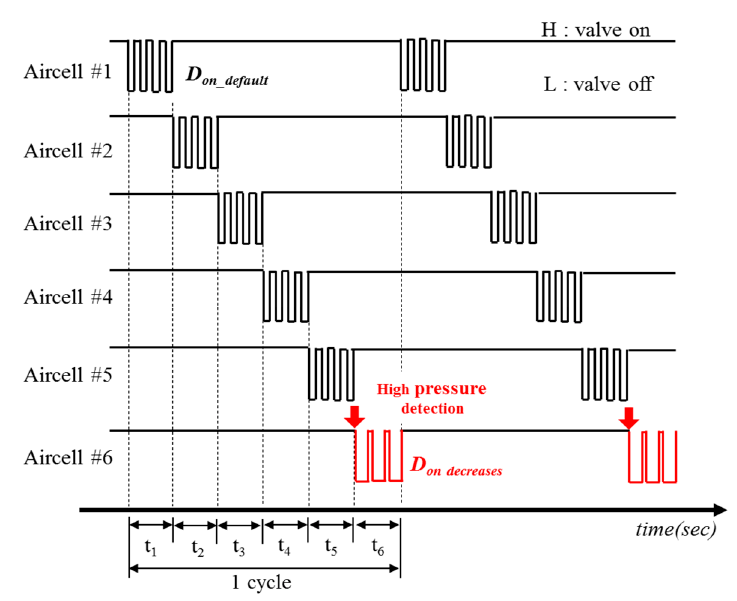
Figure 6. The timing diagram for solenoid valve control.